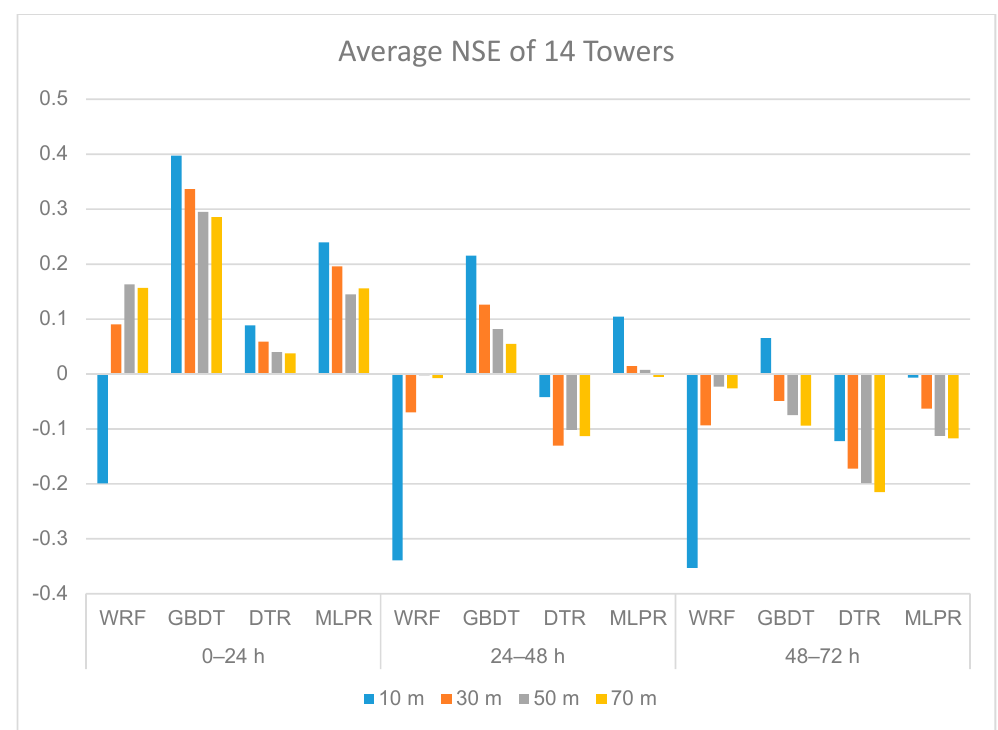
Figure 9. NSEs of the WRF original output (WRF), GBDT output (GBDT), decision tree regression output (DTR), and multi-layer perceptron regression output (MLPR).